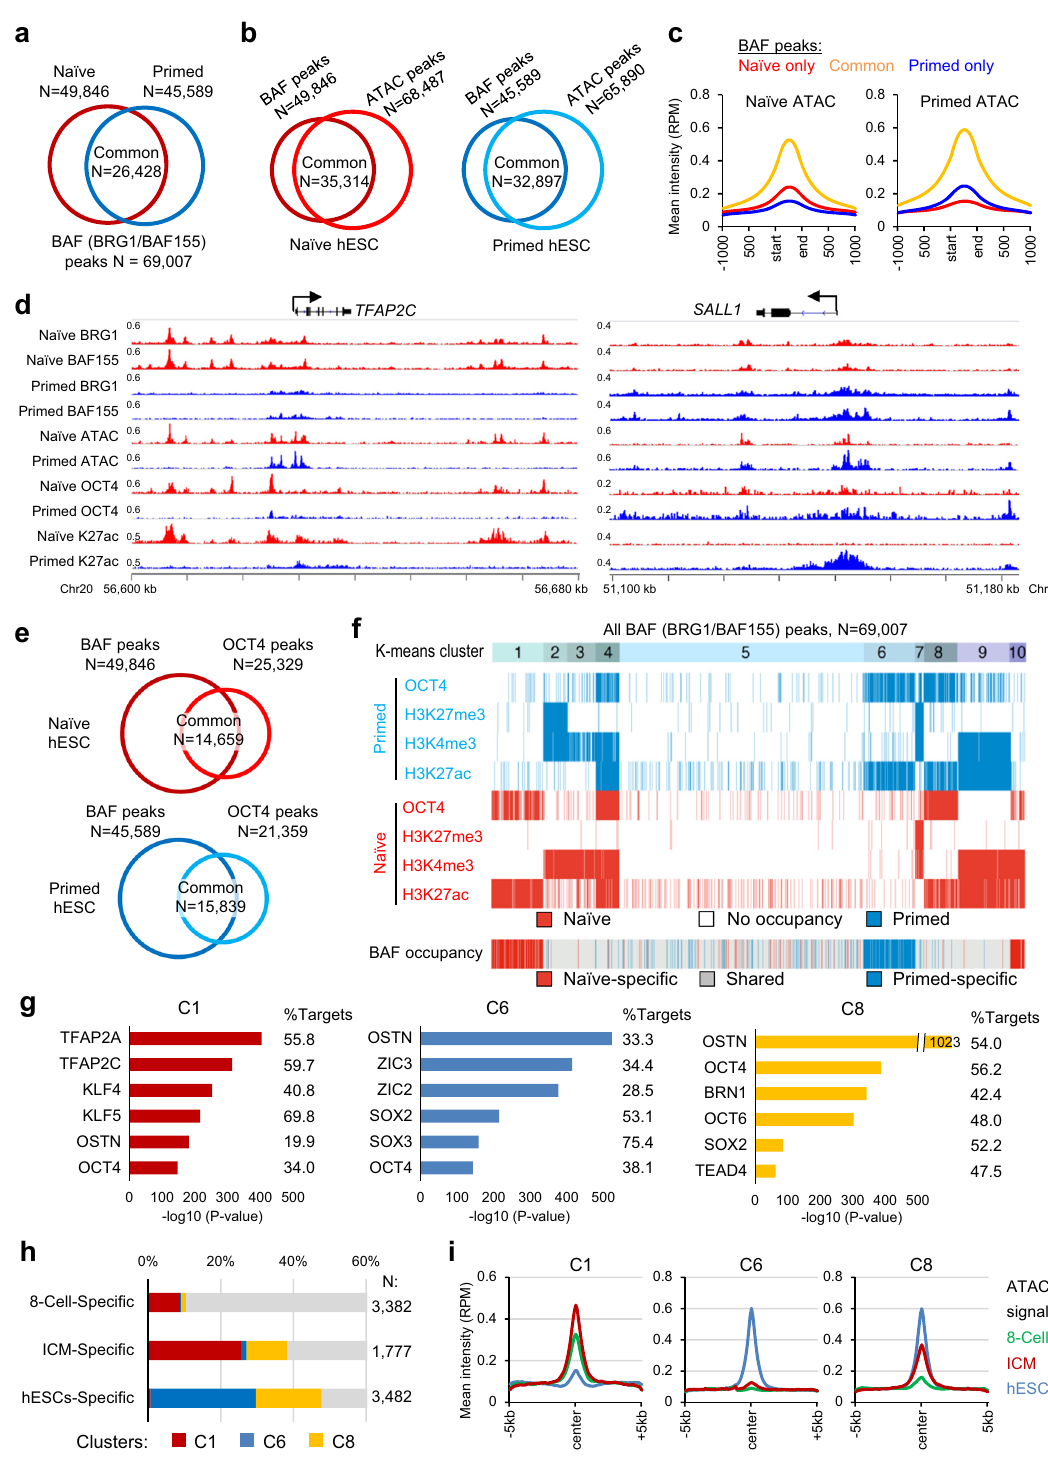
Fig. 3 Genome-wide binding pro fi les of OCT4 and BAF complexes shape the naïve- and primed-speci fi c enhancer landscapes. a Overlap of BAF (BRG1/ BAF155) peaks in naïve and primed hESCs identi fi ed by ChIP-seq analysis. b Overlap of BAF and chromatin accessibility (ATAC-seq) 48 peaks in naïve (left) and primed (right) hESCs. c Intensity plots of mean ATAC signals at naïve-only, primed-only, and common BAF peaks (shown in panel a ) in naïve (left) and primed (right) hESCs. d ChIP-seq tracks of BAF155, BRG1, ATAC-seq, OCT4, and H3K27ac at the naïve-speci fi c TFAP2C and primed-speci fi c SALL1 loci. The two tracks of each factor between naïve and primed hESCs are normalized to the same RPM (reads per million) values. e Overlap of BAF (BRG1/BAF155) and OCT4 peaks in naïve (top) and primed (bottom) hESCs. f K-means clustering analysis of all BAF ( N = 69,007) peaks (shown in panel a ) in naïve and primed hESCs identi fi ed 10 clusters with distinct patterns of OCT4 and histone marks enrichment. g Highly enriched TF binding motifs in regions C1 (left), C6 (middle), and C10 (right) from clustering analysis (shown in panel f ). OSTN: OCT4/SOX2/TCF/NANOG consensus motif 80 . h – i Overlap of 8-cell- speci fi c, ICM-speci fi c, and primed hESC-speci fi c ATAC-seq peaks ( h ) and plots of mean ATAC intensity ( i ) at clusters C1, C6, and C8 peak regions. The stage-speci fi c distal ATAC regions are from a recent study of chromatin accessibility in human preimplantation embryos 53